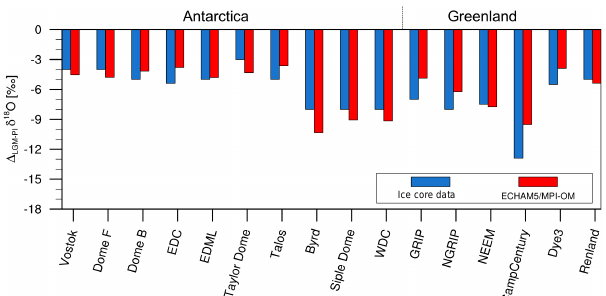
Figure 9. Comparison of annual mean LGM δ 18 O p anomalies mea- sured in ice cores from Antarctica and Greenland (blue bars) vs. the simulated ECHAM5/MPI-OM LGM-PI δ 18 O p changes (red bars) at the ice core